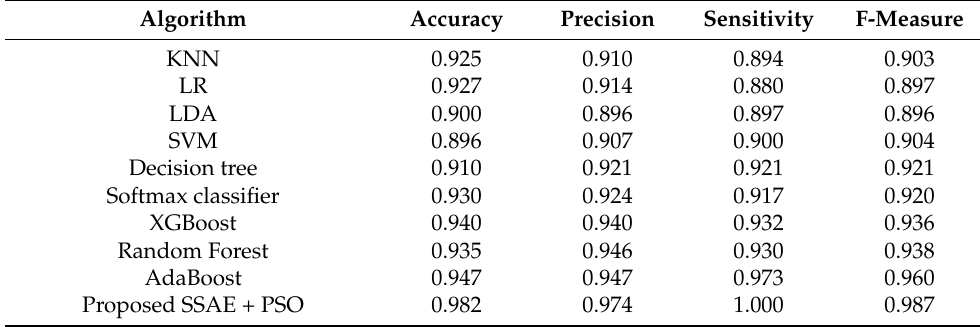
Table 6. Assessment of the performance of the algorithms using the CKD